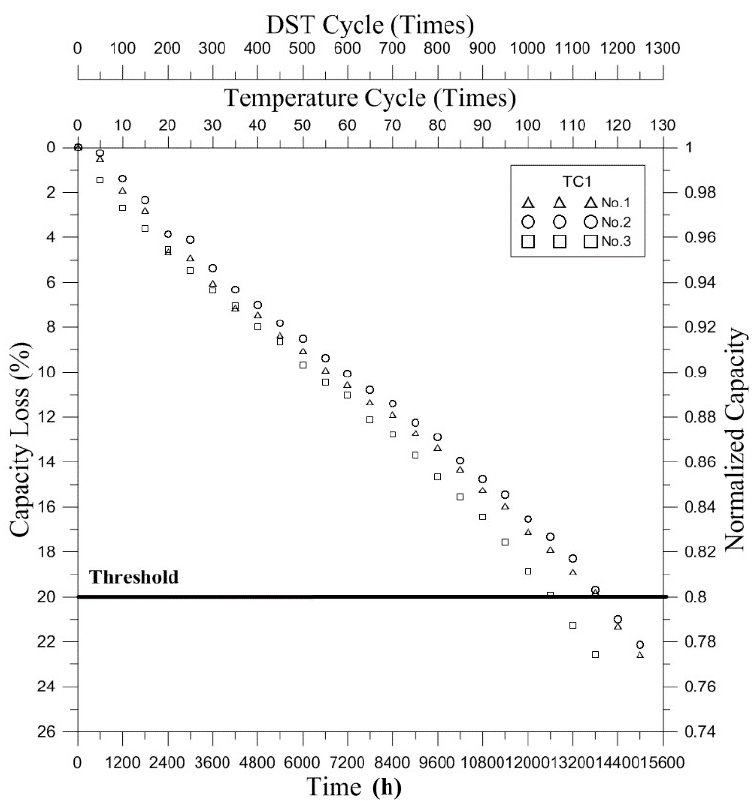
Figure 5. The capacity loss of the test batteries during D 2 SADT (TC1 condition).